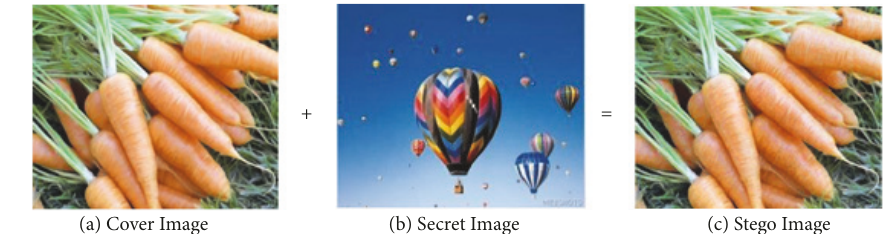
Figure 5: Experimental result.